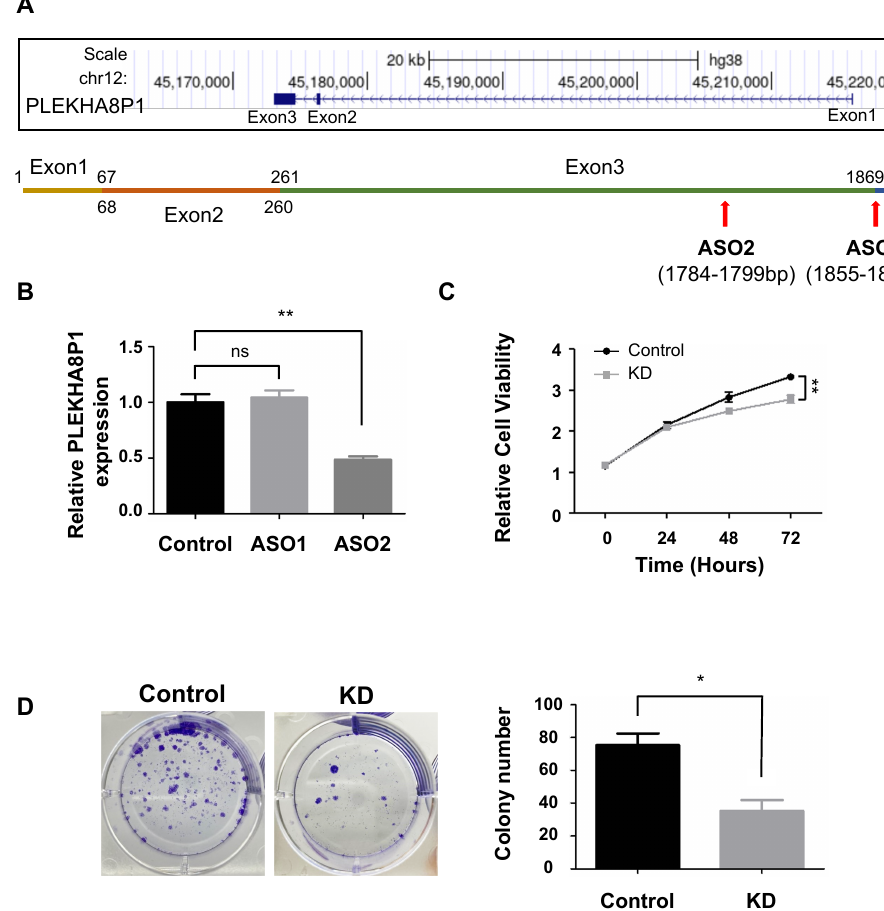
Figure 2. Downregulation of PLEKHA8P1 inhibits proliferation of HCC cells. ( A ) The human PLEKHA8P1 gene resides on chromosome 12 and consists of three exons. Antisense oligonucleotides were designed to target exon 3 (red arrows). ( B ) Knockdown efficiency was measured by qRT- PCR 48 h post-second transfection. Between two ASOs, ASO 2 significantly reduced the levels of PLEKHA8P1 . ( C ) CCK-8 assays were performed to determine cell viability at indicated time-points (0, 24, 48, 72 h). ( D ) Representative images of colony formation assays. All data were acquired from three independent experiments and p -values were determined by two-tailed unpaired t -test analysis. * p < 0.05; ** p < 0.01; ns indicates no